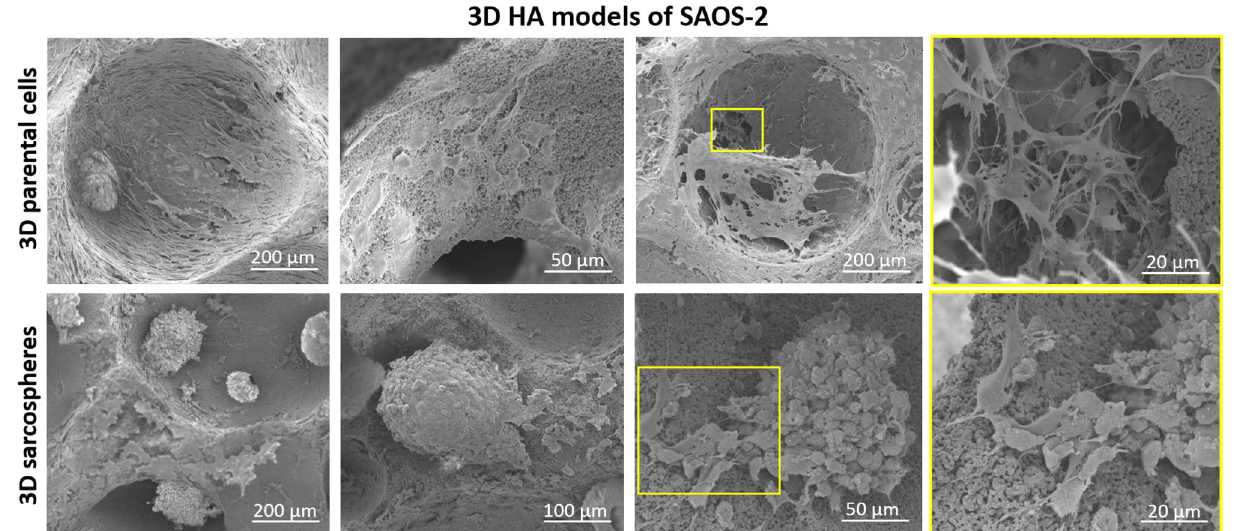
Figure 6. SEM analysis of the 3D HA model of SAOS-2 cells. The figure highlights phenotypic differences between sarcospheres and parental cells and interaction abilities of the cells toward HA